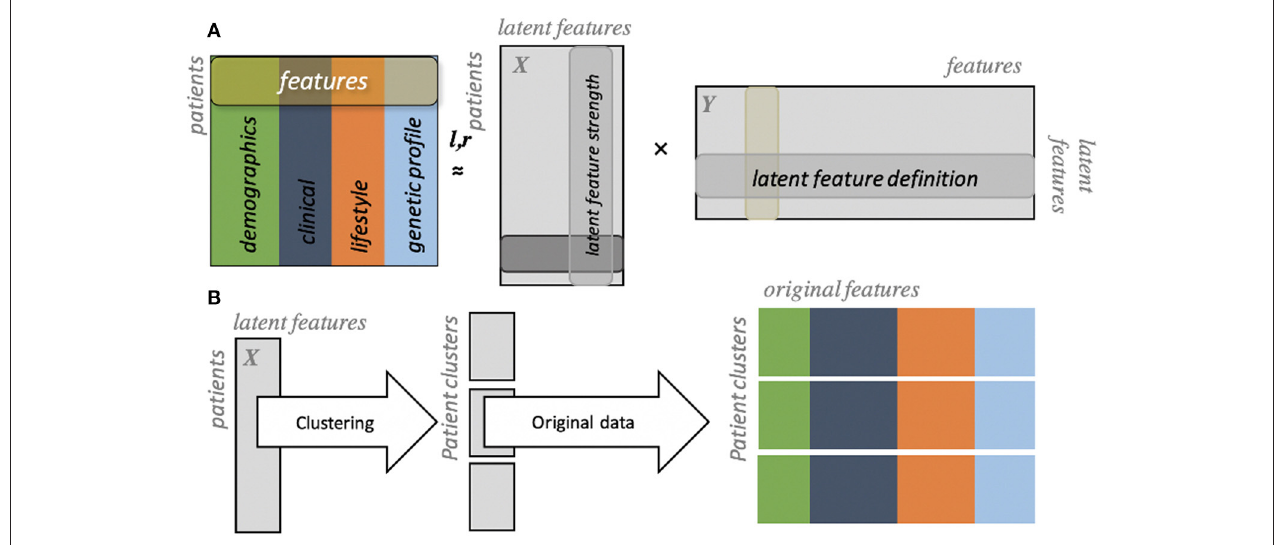
FIGURE 3 | Generalized low rank modeling. (A) Multiple features are summarized into two low rank matrices (X and Y). (B) Individuals can then be clustered using latent features, after which original features can be re-identified to summarize clinical features of each group [from Flores et al. ( 27)].